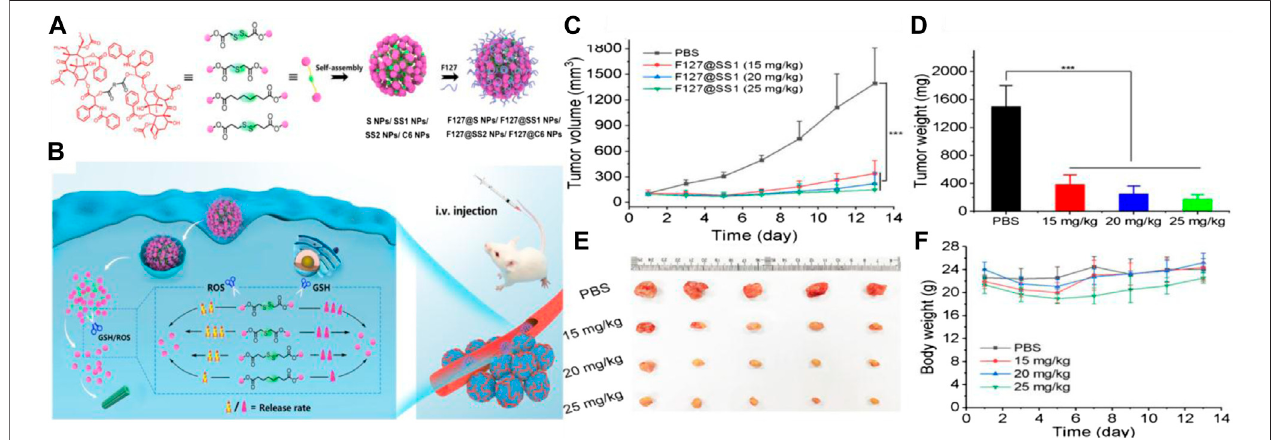
FIGURE2|(A) SyntheticroutesofthefourtypesofPTXdimerprodrugnanoparticles. (B) SchematicdiagramofROS-andGSH-responsivenessofnanoparticlesin tumor cells. (C) Curves of tumor volume treated with different prodrug nanoparticles, respectively. (D) Changes in tumor weights following treatment with different prodrugnanoparticles. (E) Photographsofexcisedtumors. (F)